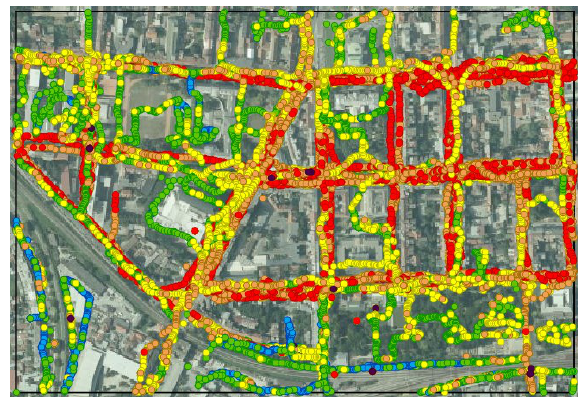
Figure 8. Classified measurements displayed in QGIS (blue and green dots represents lowest noise levels, red and purple the highest) (Vuković, 2015)